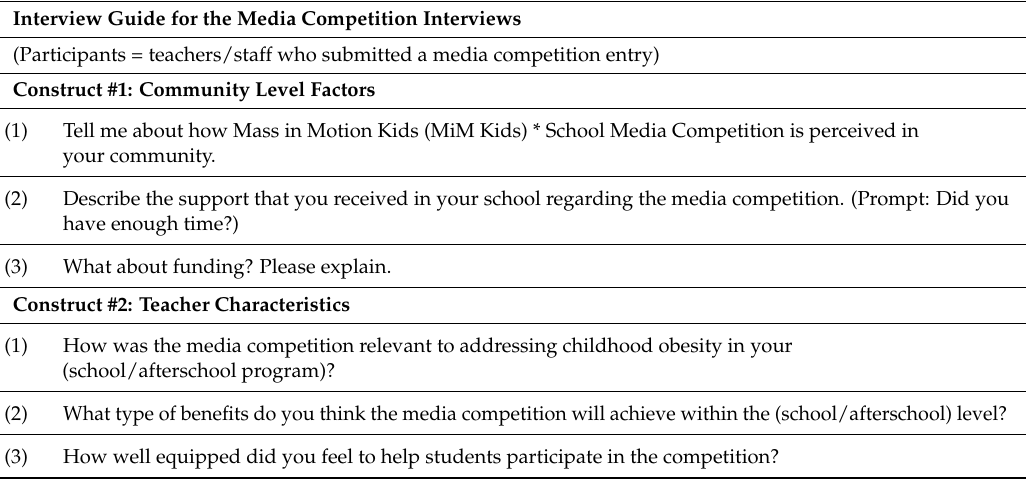
Table 1. Media Competition Interview